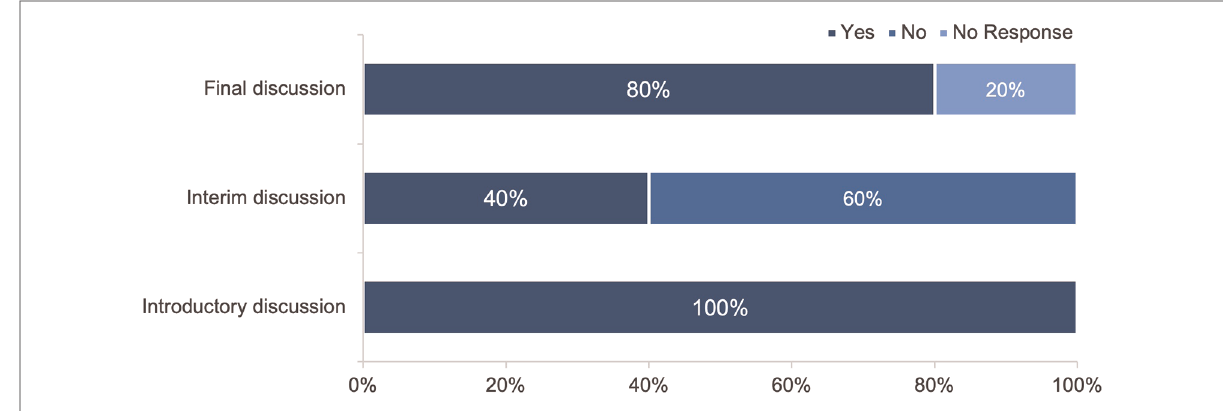
FIGURE 3 Ful fi llment of introductory, interim, and fi nal discussions ( n =15).